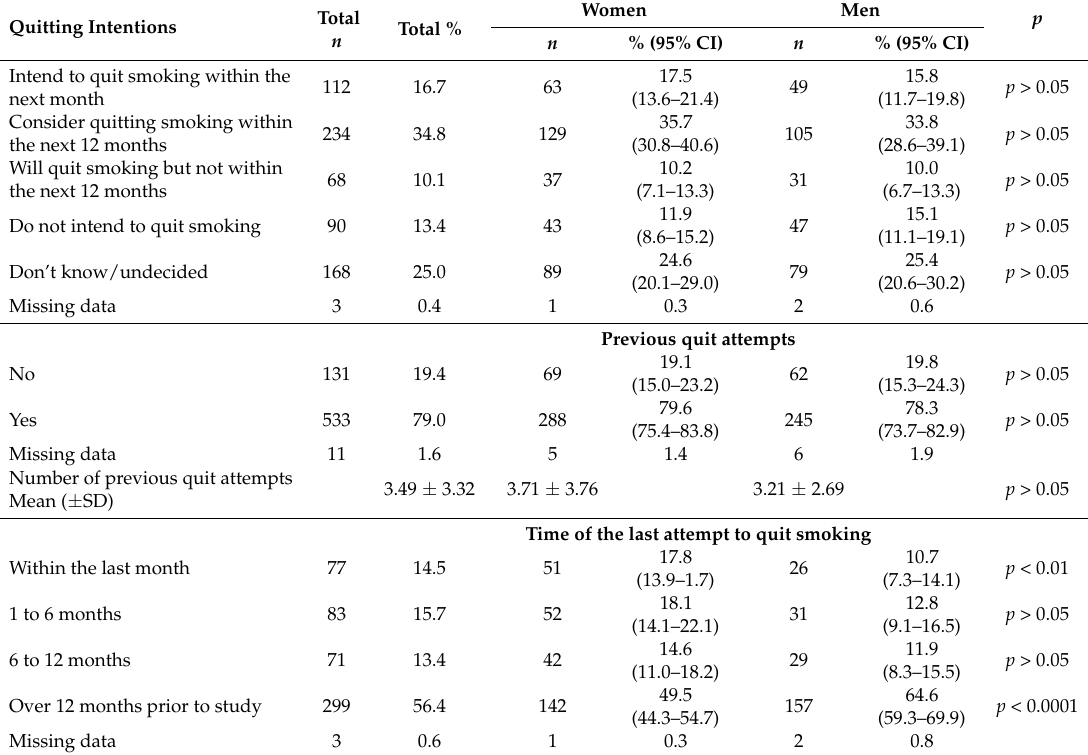
Table 3. Quitting intentions and attempts among the daily and occasional smokers